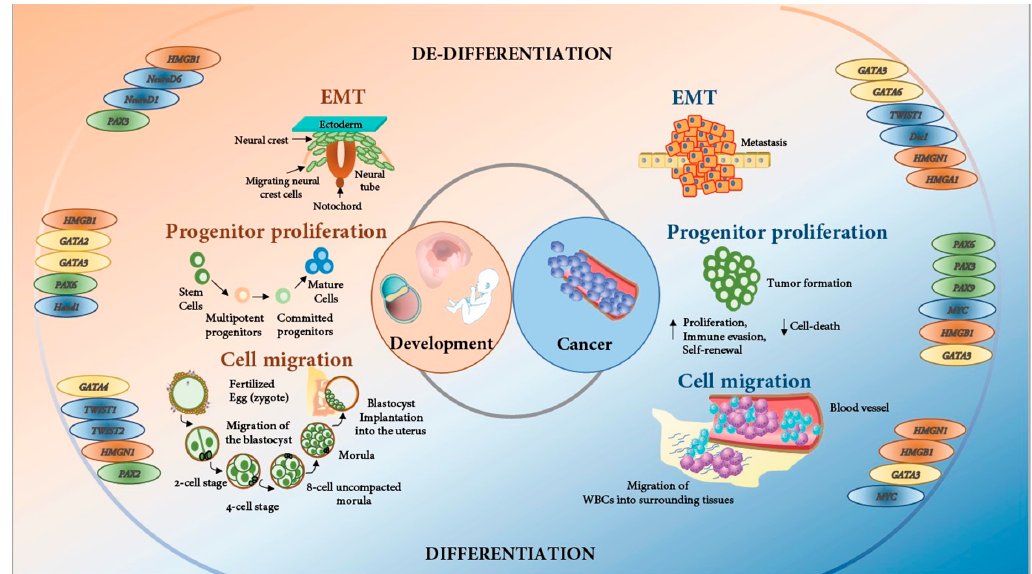
Figure 1. Development and Cancer: Two sides of the same coin. Schematic representation of parallel processes in development and cancer. Three examples of these processes have been outlined: i)